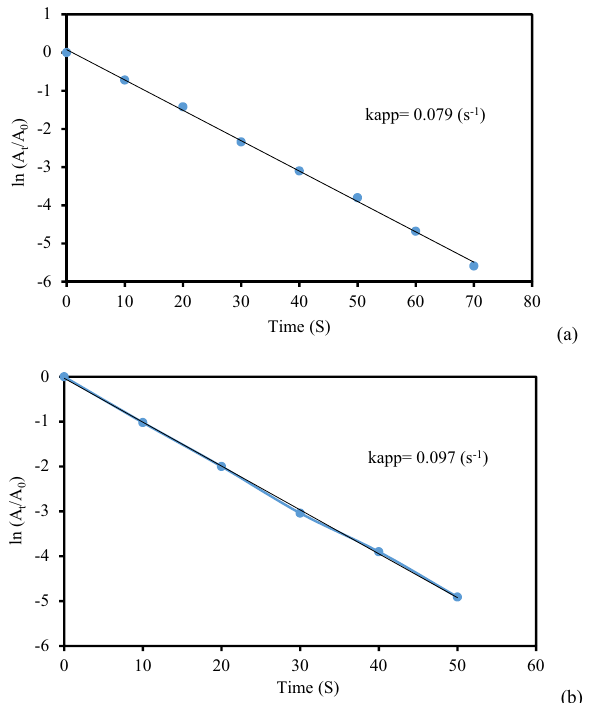
Figure 13. The kinetic plots (lnA t /A 0 vs t) for the reduction of RhB using ( a ) 3 mg and ( b ) 4 mg of KIT-5- biguanidine-Au(0) nanocomposite.